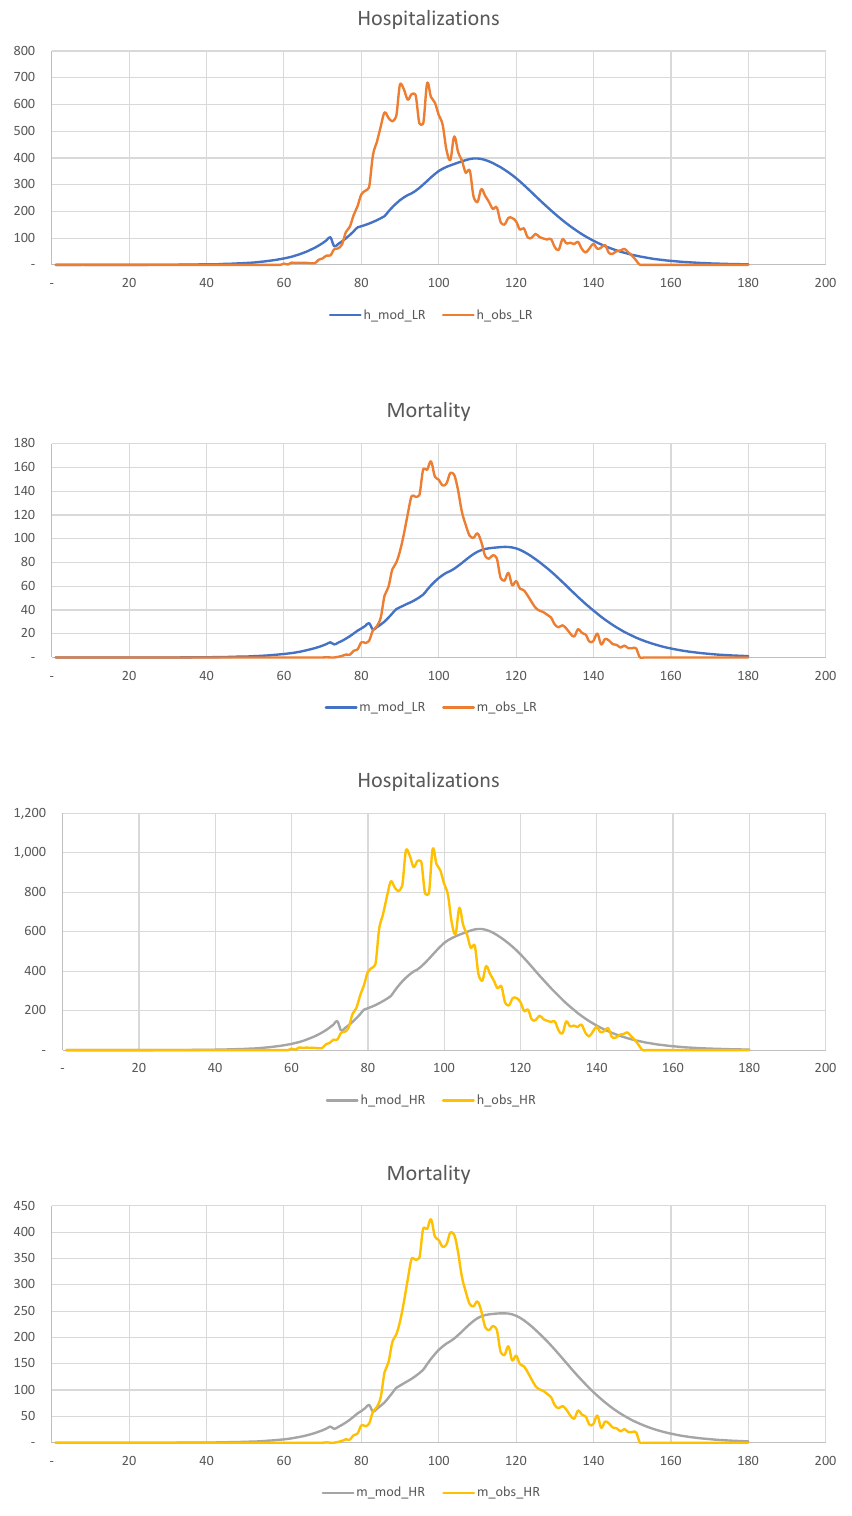
Figure 20. Hospitalization and mortality, assuming that the quarantine is imposed three weeks earlier than in